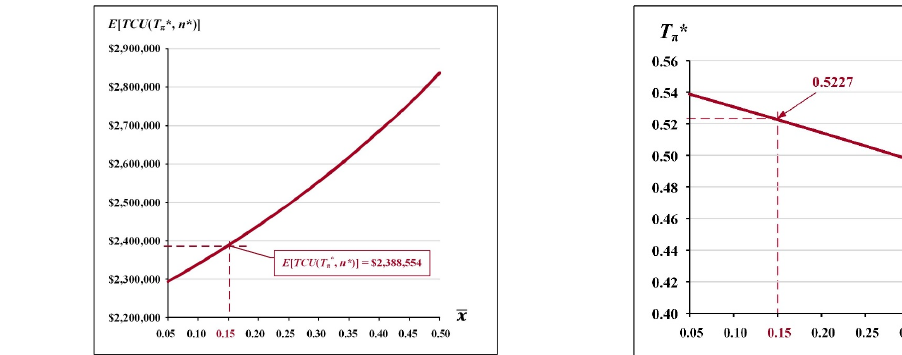
Fig. 8. E [ TCU ( T π *, n *)]’s behavior relating to the mean scrap rate